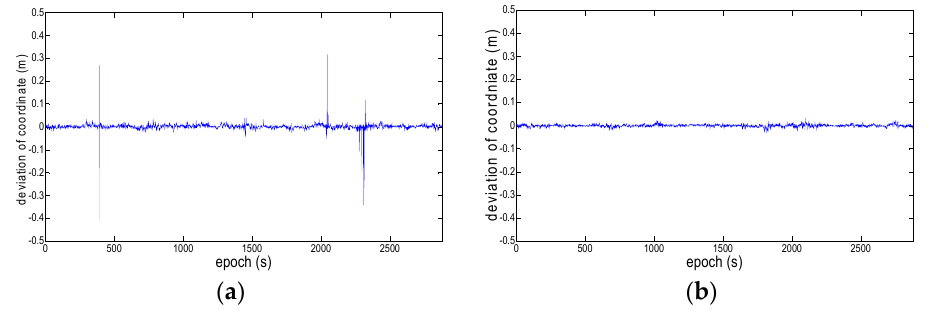
Figure 5. Deviation of coordinate (North). ( a ) without robust estimation; ( b ) with robust estimation. ISPRS Int. J. Geo-Inf. 2017 , 6 , 46